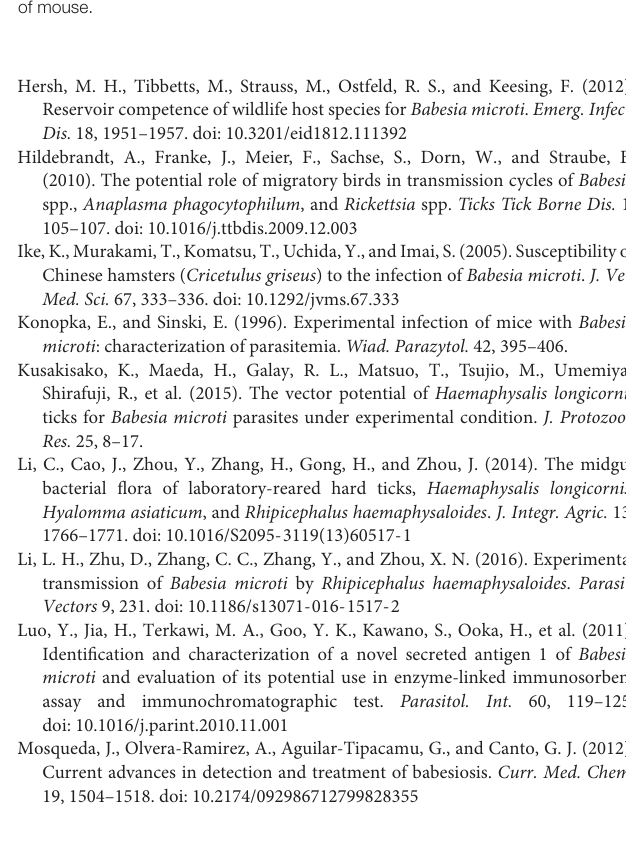
FIGURE S1 | Parasitemia in the infected rats. The error bars represent three biological replicates. FIGURE S2 | DNA detection in the infected rats. The error bars represent three biological replicates. FIGURE S3 | Blood examination of the infected chicken. The error bars represent three biological replicates. FIGURE S4 | Blood examination of the infected pig. The error bars represent three biological replicates. FIGURE S5 | Blood examination of the infected dog. The error bars represent three biological replicates. FIGURE S6 | Blood examination of the infected goat. The error bars represent three biological replicates. FIGURE S7 | The parasites in the blood smear of mouse experimentally transmitted by H. longicornis nymphs. The arrows indicated the parasites in RBC of